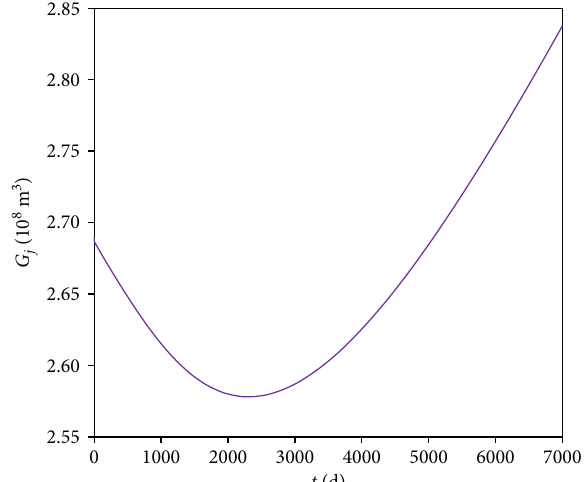
Figure 27: The estimated pro fi le of G